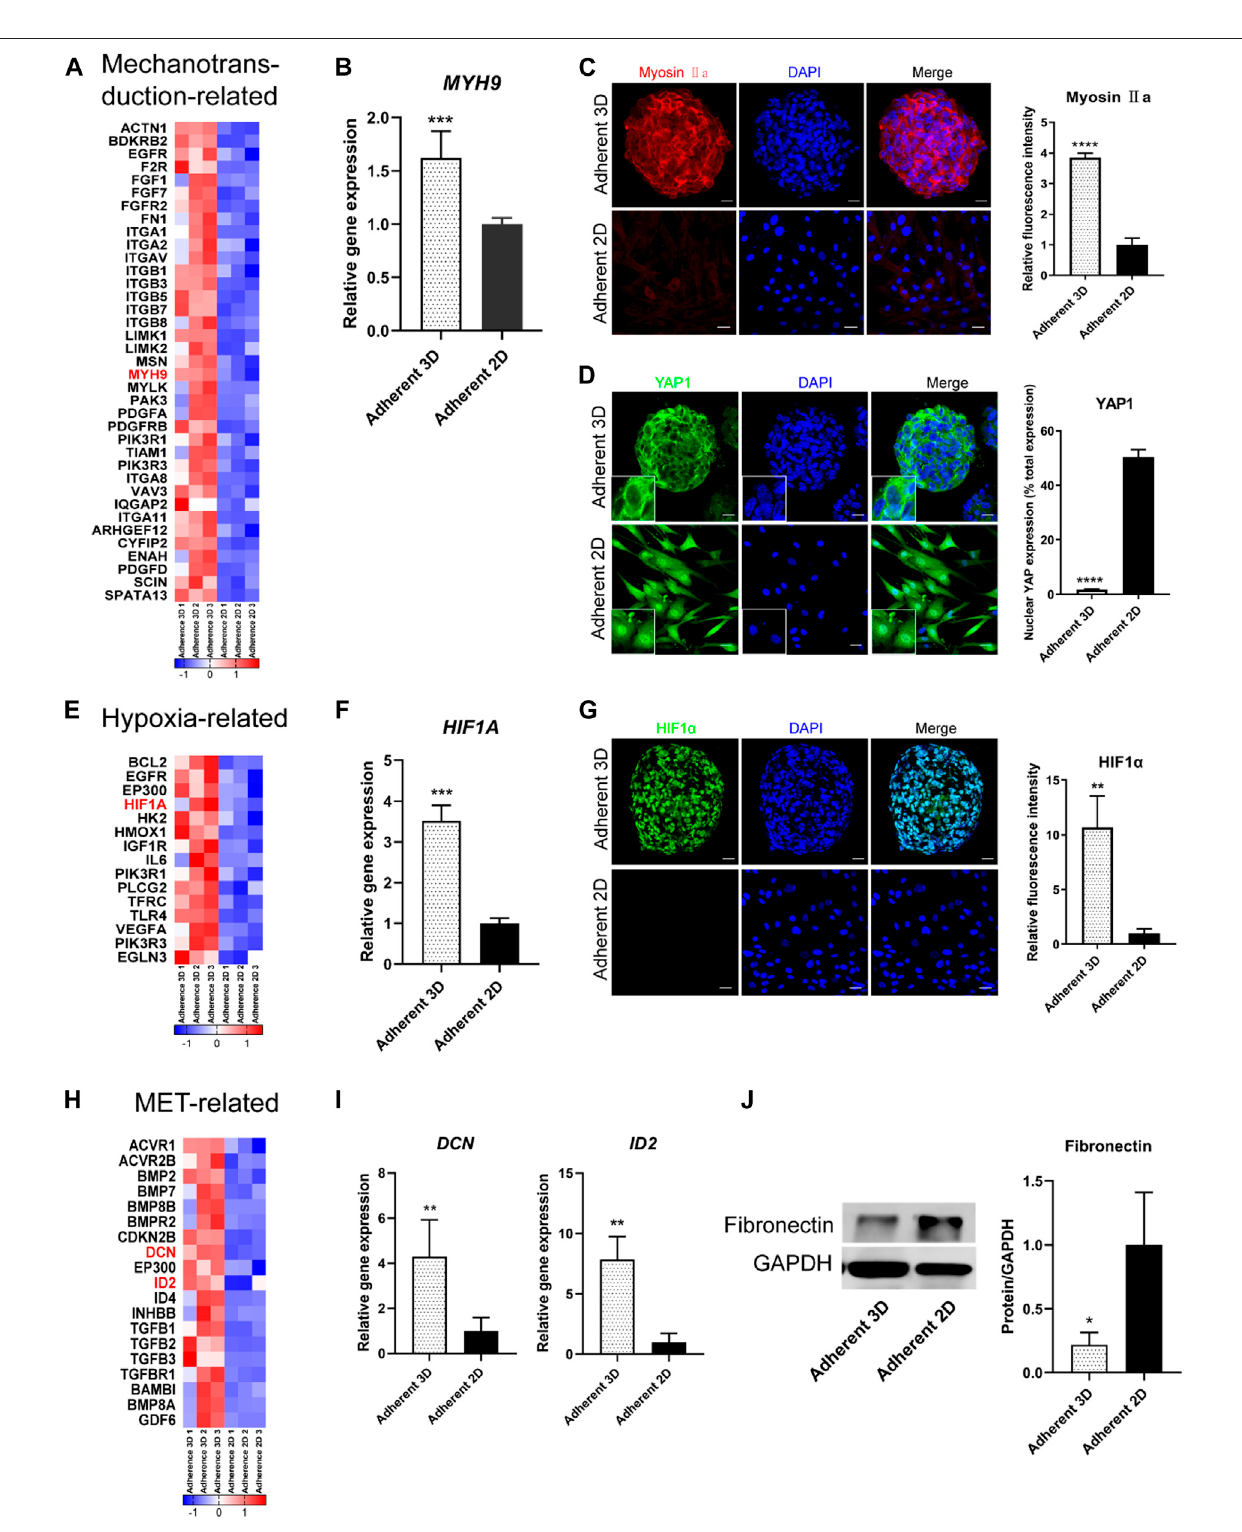
FIGURE6| AnalysisoftheeffectsofPDMSonkeratocytespheroids. (A,E,H) TheheatmapshowstheDEGsofmechanotransduction-related,hypoxia-relatedand MET-related signaling pathways. (B – D,F – J) PDMS acts on these three signaling pathways, which were validated by IF, qPCR and WB analyses. (* p < 0.05; ** p < 0.01; *** p < 0.001; **** p < 0.0001). Scale bars: 20 μ m for (C,D,G) .